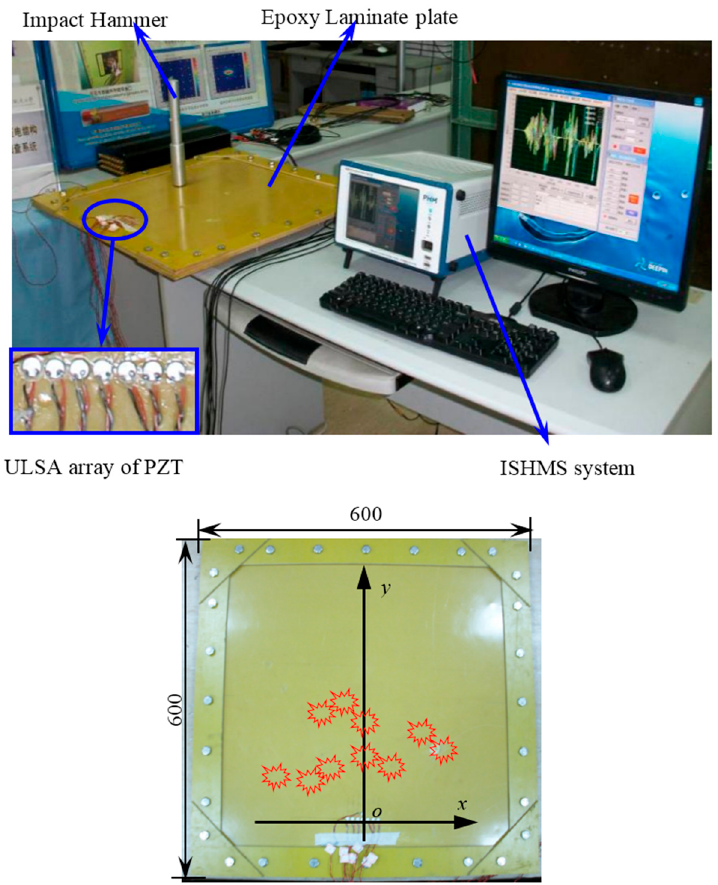
Figure 3. Experiment setup, ULSA arrangement, and impact applied positions (mm).